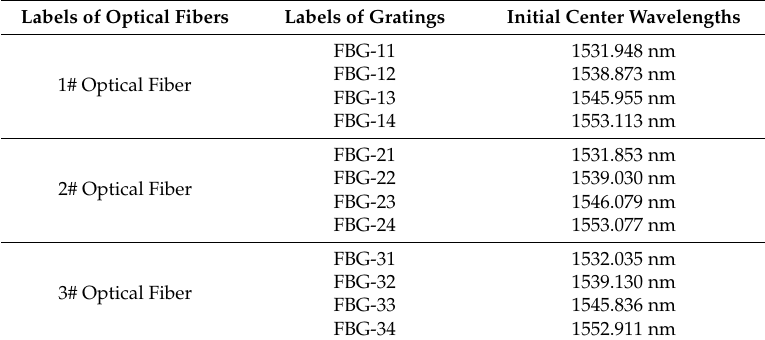
Table 3. The initial center wavelengths of FBGs.